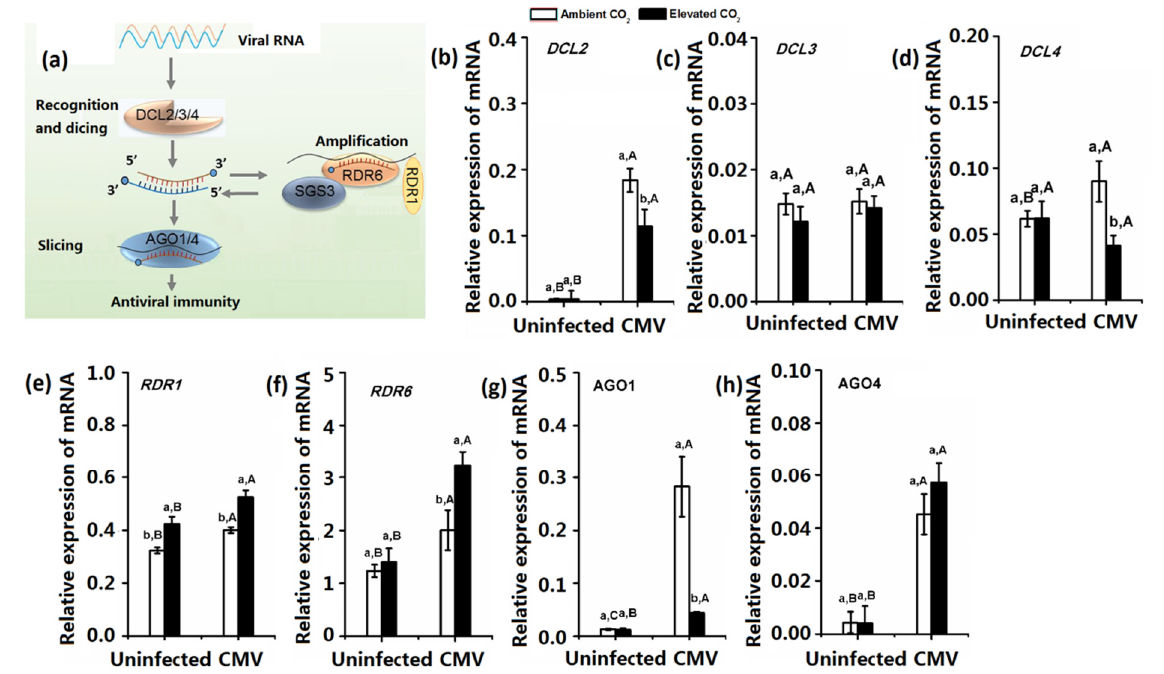
Figure 2. Expression of key genes associated with plant systemic RNA silencing of N. tabacum that were grown under ambient CO 2 and elevated CO 2 2 weeks after CMV infection or mock inoculation. ( a ) Representation of the key genes involved in virus-induced RNA silencing occurs in three steps: initiation, amplification and spreading. The expression of ( b ) DCL2, ( c ) DCL3, ( d ) DCL4, ( e ) RDR1, ( f ) RDR6, ( g ) AGO1 and ( h ) AGO4. Data represent means ± SE (Tukey’s multiple range test, p < 0.05). Different lowercase letters indicate significant differences between ambient CO 2 and elevated CO 2 within the same virus treatment. Different uppercase letters indicate significant differences among virus treatment within the same CO 2 treatment ( p < 0.05).